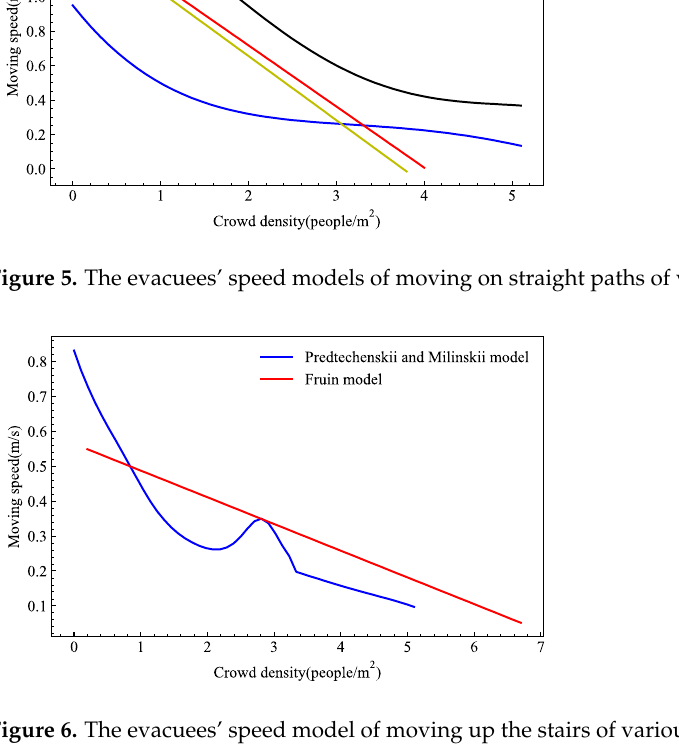
Figure 6. The evacuees’ speed model of moving up the stairs of various scholars.